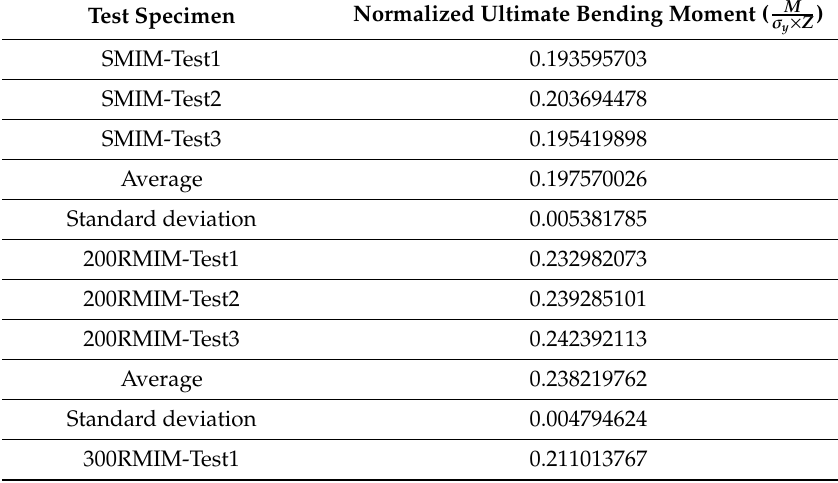
Table 4. The ultimate normalized bending capacity of specimens in the minor axis tests .